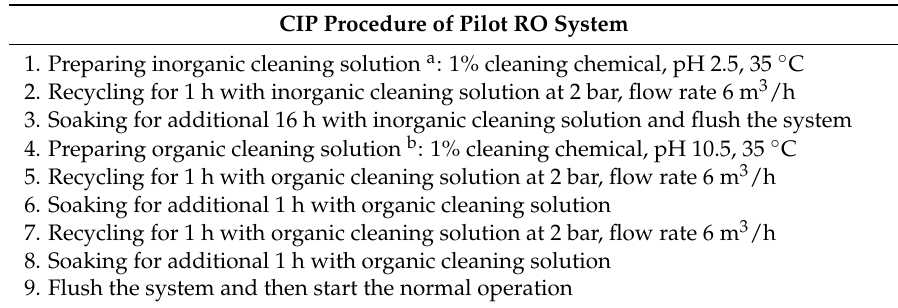
Table 5. CIP procedure applied in this